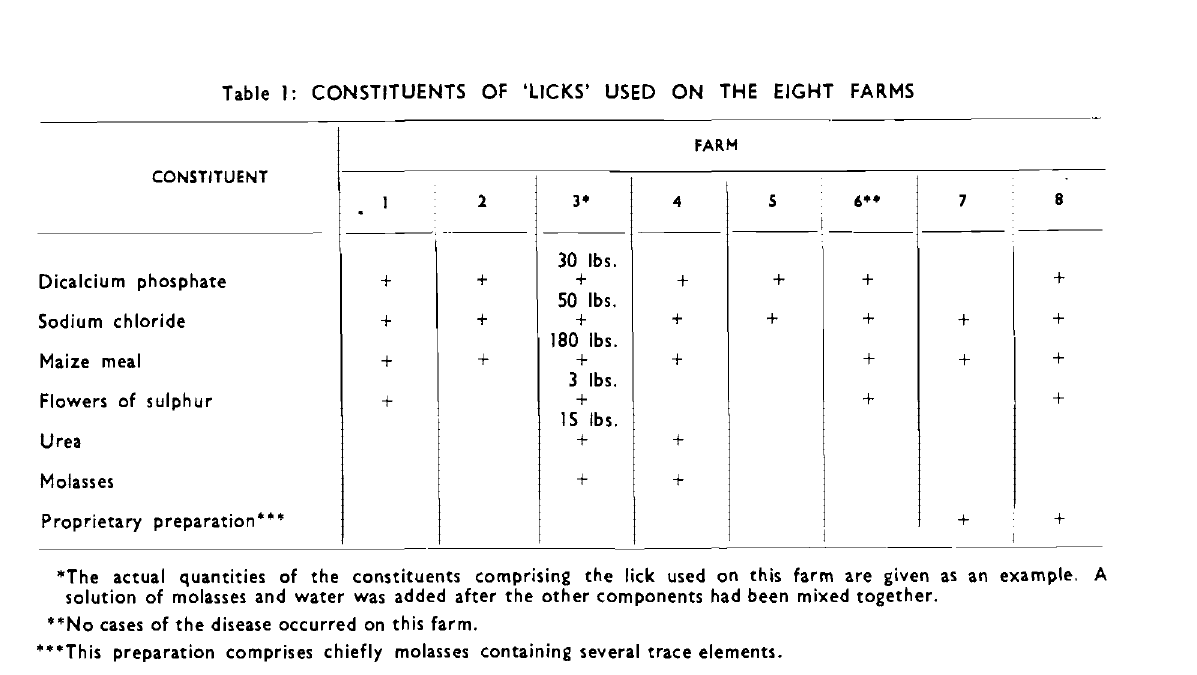
Table I: CONSTITUENTS OF 'LICKS' USED ON THE EIGHT FARMS